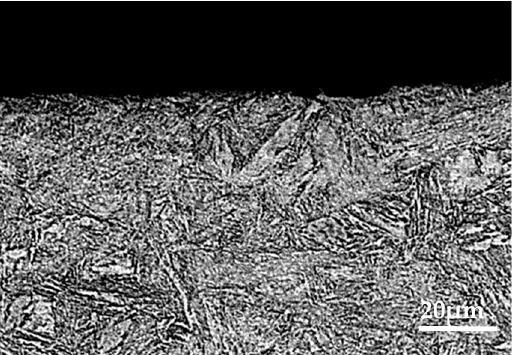
Figure 22. Profile photo of the disc material after intermittent brake wear at an ambient temperature of − 30 °C.